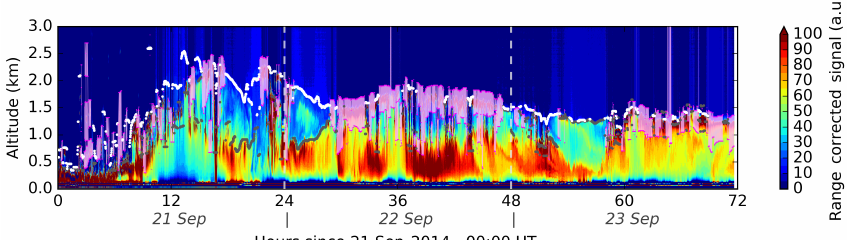
Figure 2. Vertical distribution of atmospheric particles detected over Lille by lidar observations performed from 21 to 23 September 2014. The BASIC algorithm detects meteorological clouds above 300ma.s.l. (pink), the top of the aerosol layer (white) and a heavy load of low- tropospheric aerosols including volcanic particles (lying at an altitude below ∼ 1.2km), which is characterized by a strong backscatter signal